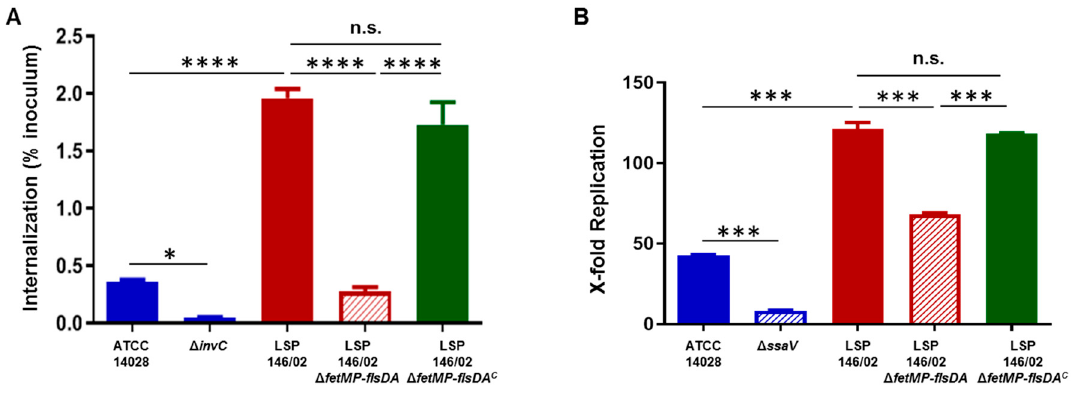
Figure 5. Invasion of epithelial HeLa cells ( A ) and replication within RAW264.7 macrophages ( B ) by wild-type S. Typhimurium LSP 146/02, its Δ fetMP - flsDA isogenic derivative, and the latter strain complemented with the cloned fetMP - flsDA genes (LSP 146/02 Δ fetMP - flsDA C ). The data shown are the mean values ± standard deviations of three biological replicates. Statistical significance (**** p < 0.0001; *** p < 0.001; ** p < 0.01; * p < 0.05; n.s., not significant) was determined by one-way ANOVA and the Tukey´s post-test.